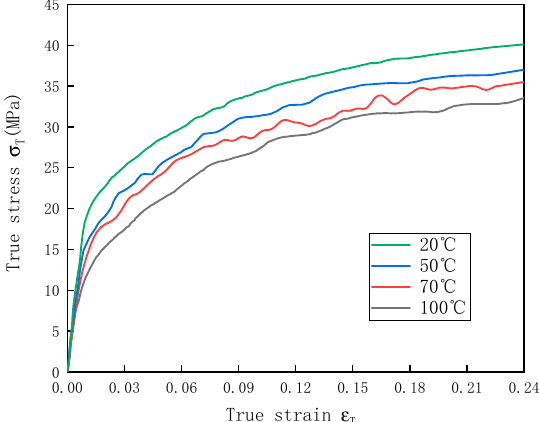
◦ C and a strain rate of 1300 s − 1 .